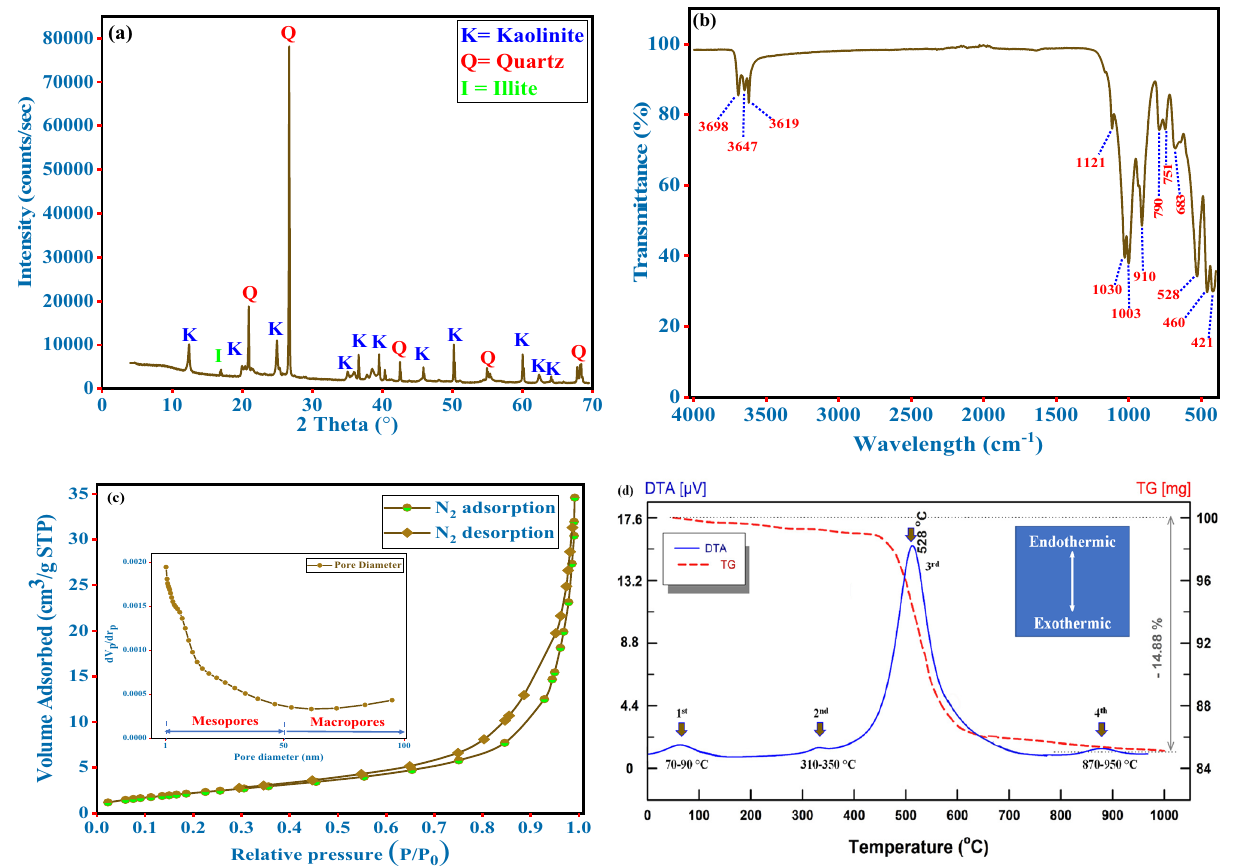
Figure 3. Shows the studied sample characterization: ( a ) XRD patterns, ( b ) FT-IR spectra, ( c ) N 2 adsorption– desorption isotherm, and ( d ) DTA/TG